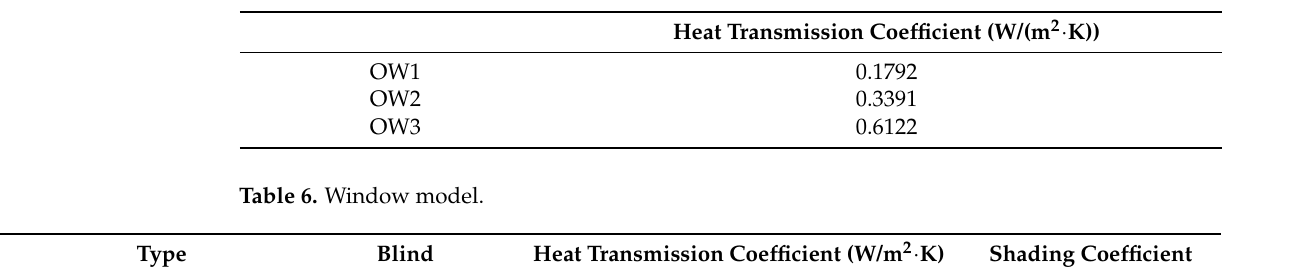
Table 5. Exterior wall model.